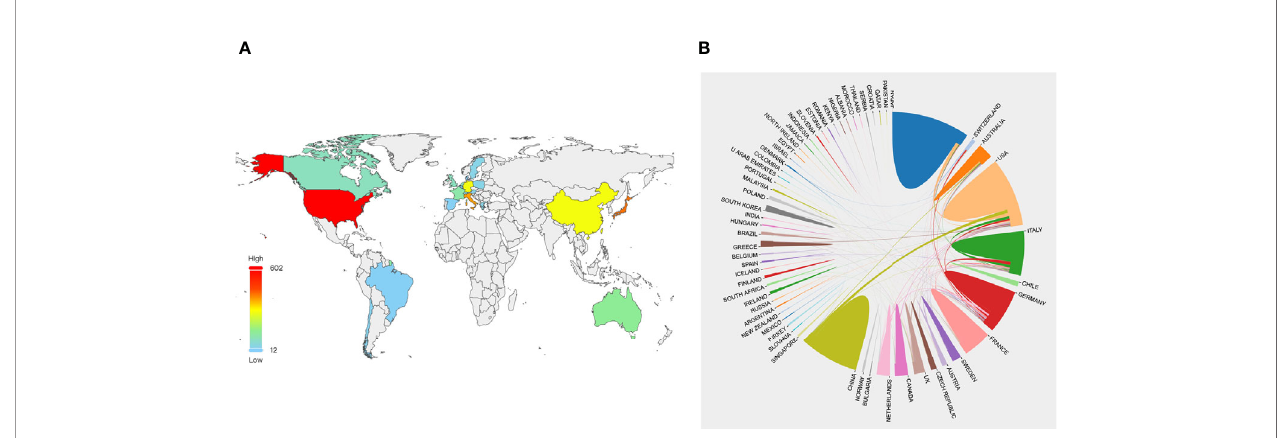
FIGURE 3 | The distribution of countries or regions in PA research. (A) Distribution of PA literatures in the world map. The color of each country or region on the world map represents the amount of literature published, according to the color gradient in the lower left corner. (B) The network map of cooperation between countries or regions. Different colors represent different countries or regions, the area of each color represents the amount of literature published in each country or regions, and the thickness of the connecting line indicates the cooperation